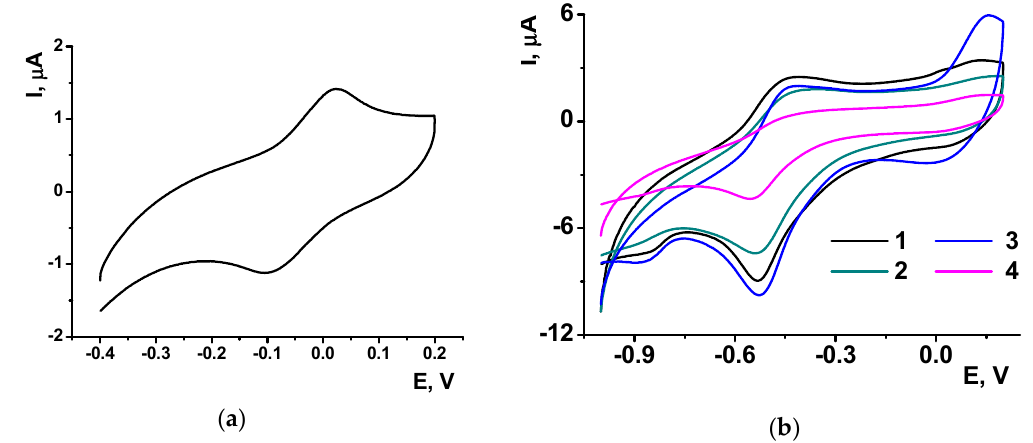
Figure 8. Cyclic voltammogram recorded on glassy carbon electrode covered with CB (2 μ L of 0.1 mg/mL suspension per electrode) and P[5]A (2 μ L of 0.1 mM solution per electrode) ( a ); Cyclic voltammograms of the poly-NR recorded in the absence of the monomer dye, the CB/P[5]A layer was obtained with 0.05 (1), 0.1 (2), 0.5 (3) and 1.0 (4) mM P[5]A in the aliquot of 2 μ L ( b ). All the measurements in 0.025 M phosphate buffer, pH 7.0. Scan rate: 50 mV/s.